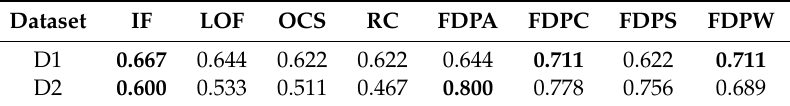
Table 3. The outlier detection rate of isolation forest (IF), local outlier factor (LOF), one-class SVM FDP Ward’s (FDPW) algorithms in the synthetic dataset experiments. The highest value of the FDP algorithms and the highest value of the comparison algorithms are respectively marked in bold